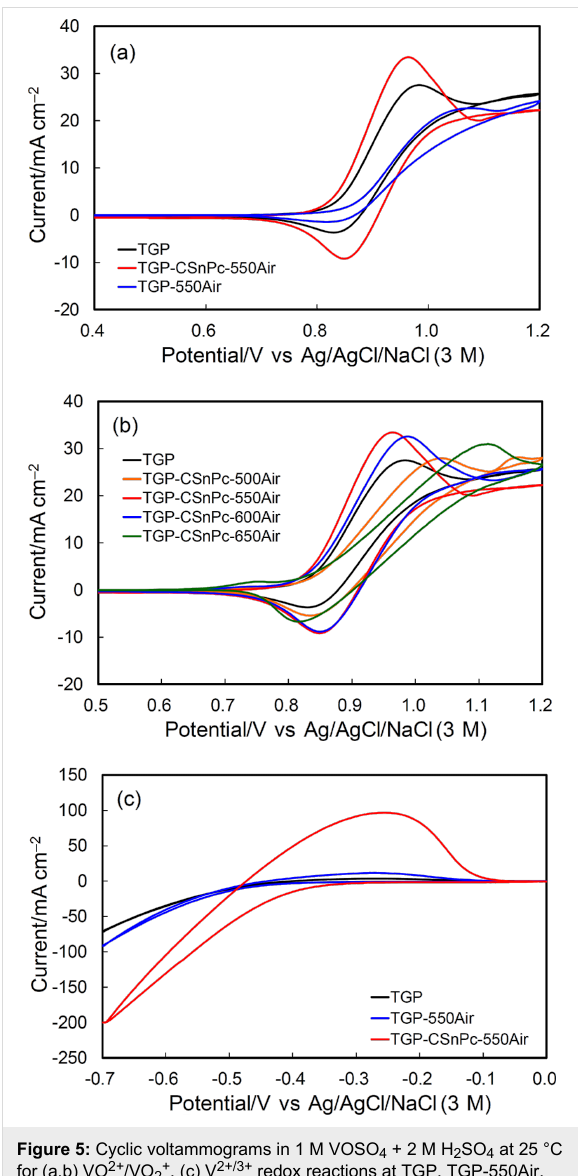
Figure 5: Cyclic voltammograms in 1 M VOSO 4 + 2 M H 2 SO 4 at 25 °C for (a,b) VO 2+ /VO 2+ , (c) V 2+/3+ redox reactions at TGP, TGP-550Air, TGP-CSnPc- T Air ( T =500, 550, 600 and 650 °C). The reference elec- trode was Ag/AgCl/NaCl (3 M). The counter electrode was carbon cloth. Scan rates were (a,b) 1 mV·s − 1 and (c) 50 mV·s − 1